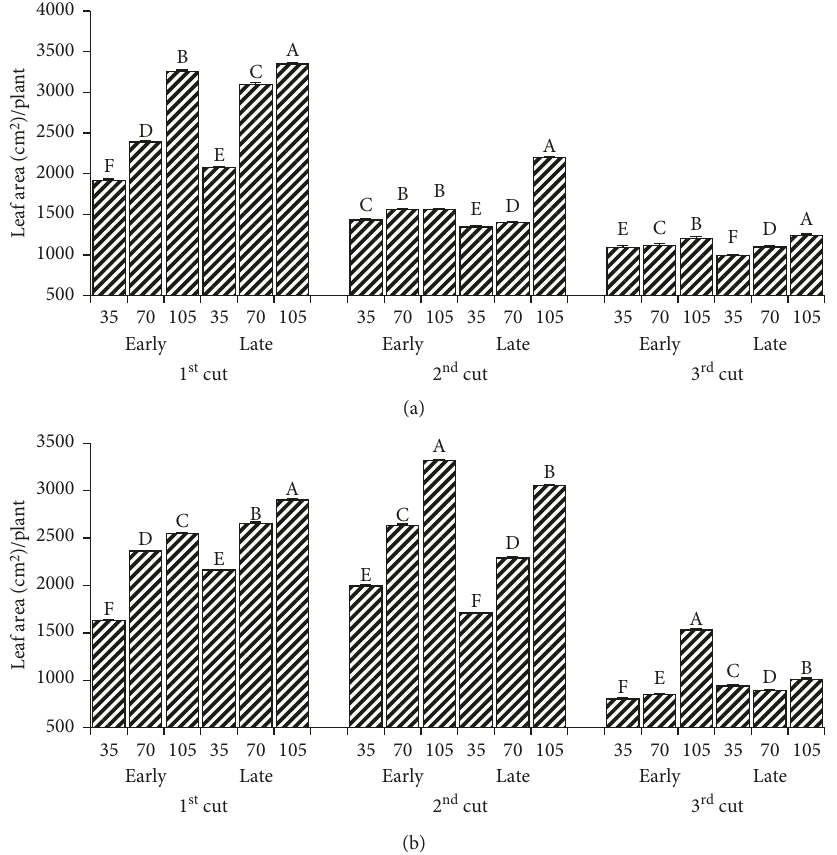
Figure 2: Leaf area cm 2 /plant of Sudan grass as affected by the interaction between cutting date and nitrogen fertilizer levels at the three cuts in the first season (a) and the second season (b). The bars on the top of column represent the SE for each